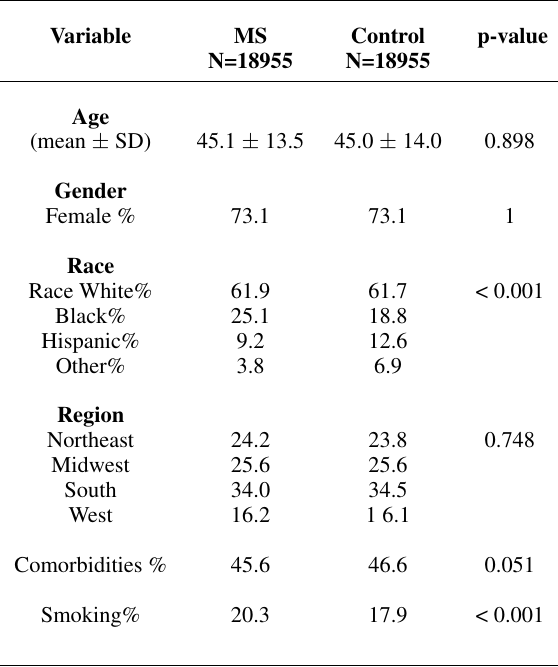
Table 1. Hospital admissions with migraine among MS and Con- trols for 2010-2013.